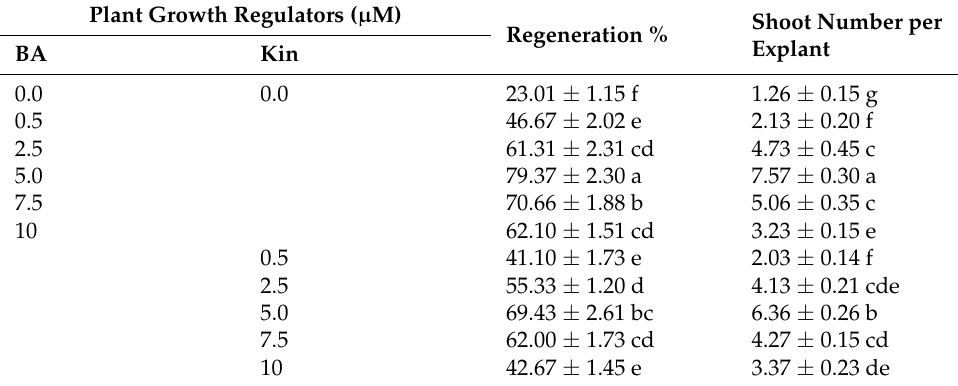
Table 3. Effect of 6-benzyladenine (BA) and kinetin (Kin) on shoot regeneration from axillary node explants of Plectranthus amboinicus